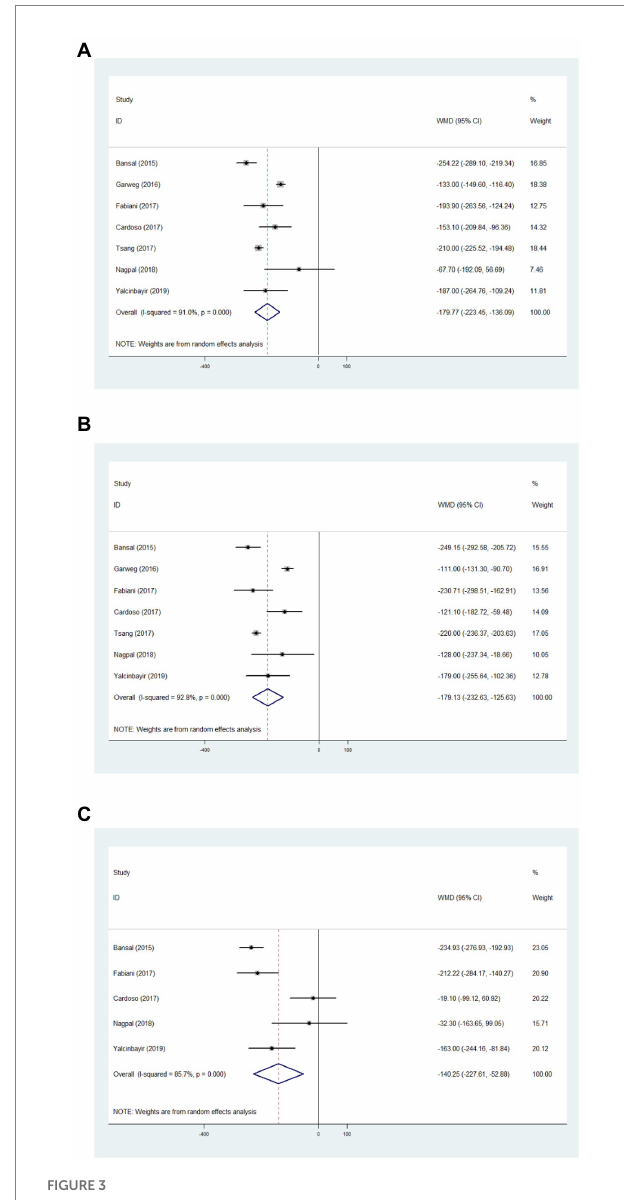
FIGURE 2 Forest plot showing best corrected visual acuity changes from baseline to 1 (A) , 3 (B) , and 6 months (C) .